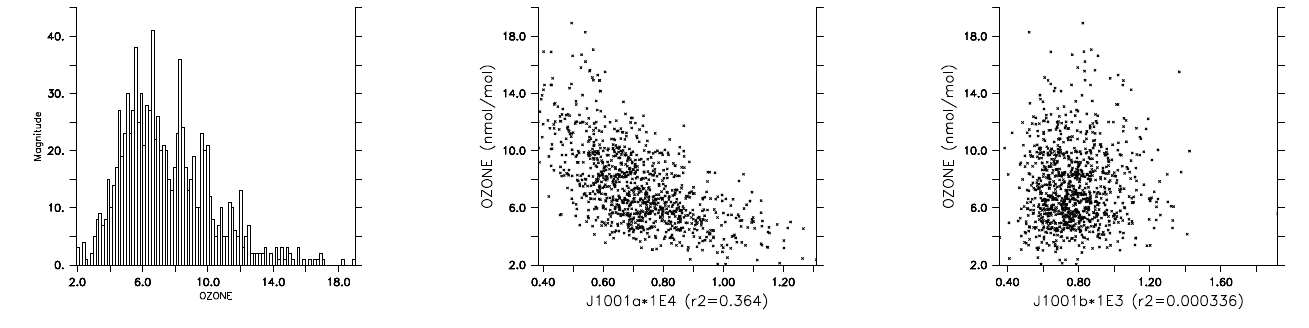
Fig. 4. Example results of Monte-Carlo simulations using a simple chemistry mechanism (tropospheric conditions, gas-phase chemistry with- out any non-methane hydrocarbons). The first figure is a histogram showing the distribution of steady-state O 3 mixing ratios (nmol mol − 1 ) in 1000 model runs. The other figures are scatter plots of O 3 against individual gas-phase photolysis rate coefficients (in s − 1 ). It can be seen that O 3 decreases with increasing values of J1001a (O 3 + hν → O ( 1 D ) ). In contrast, its dependence on the photolysis rate J1001b (O 3 + hν → O ( 3 P ) ) is statistically